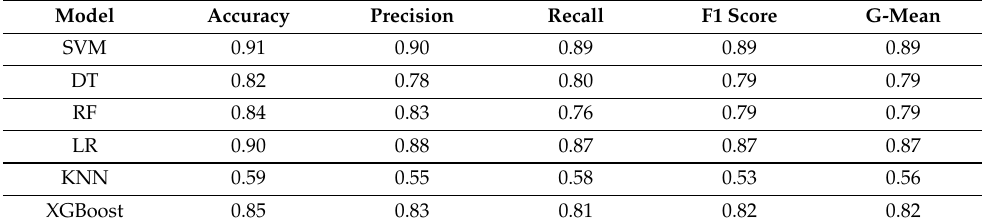
Table 13. The results of models using TF-IDF features.